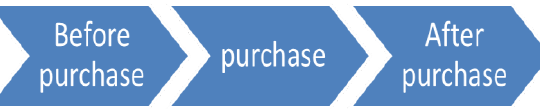
Figure 2 - B2B customer travel